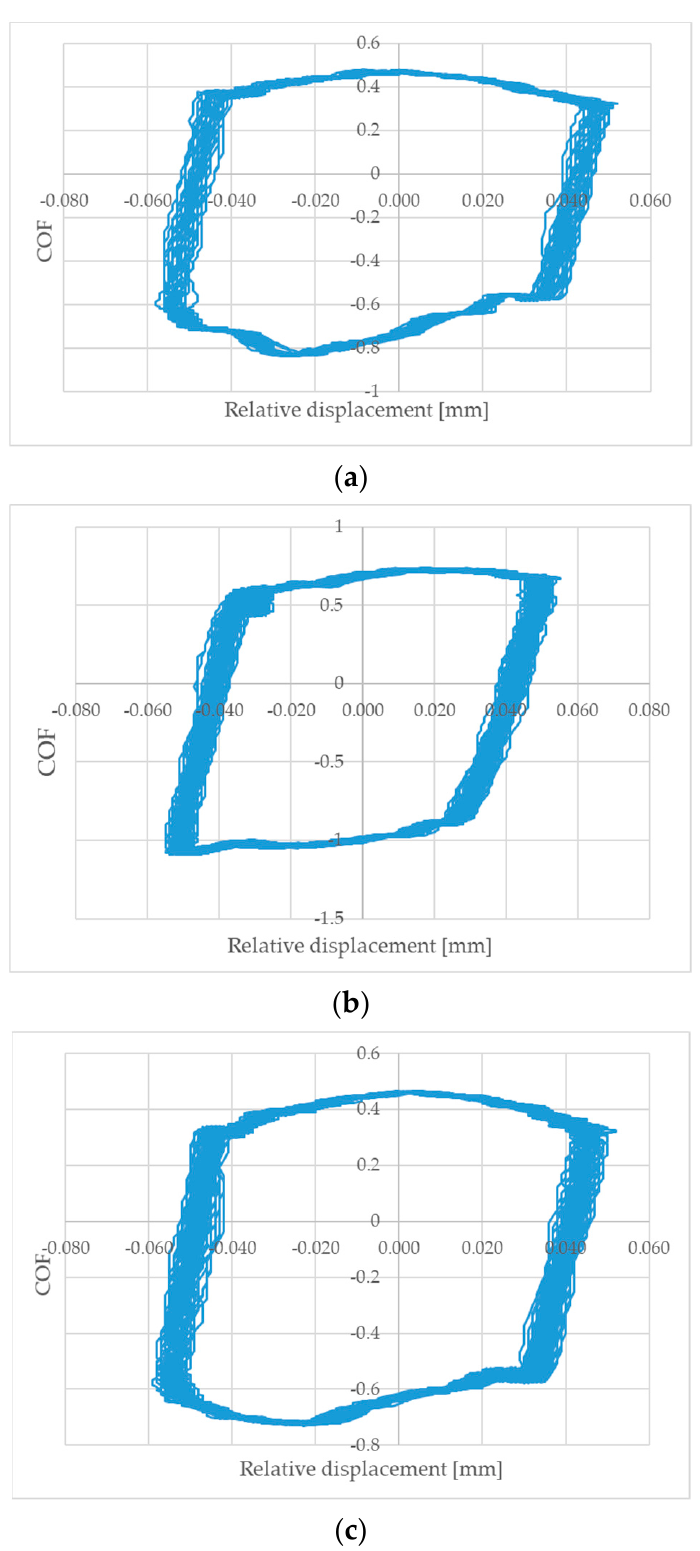
Figure 7. Fretting loops for sliding pairs with discs: ( a ) milled − normal force 50 N, ( b ) burnished − pressure 30 MPa and normal force 20 N, ( c ) burnished − pressure 30 MPa and normal force 50 N.